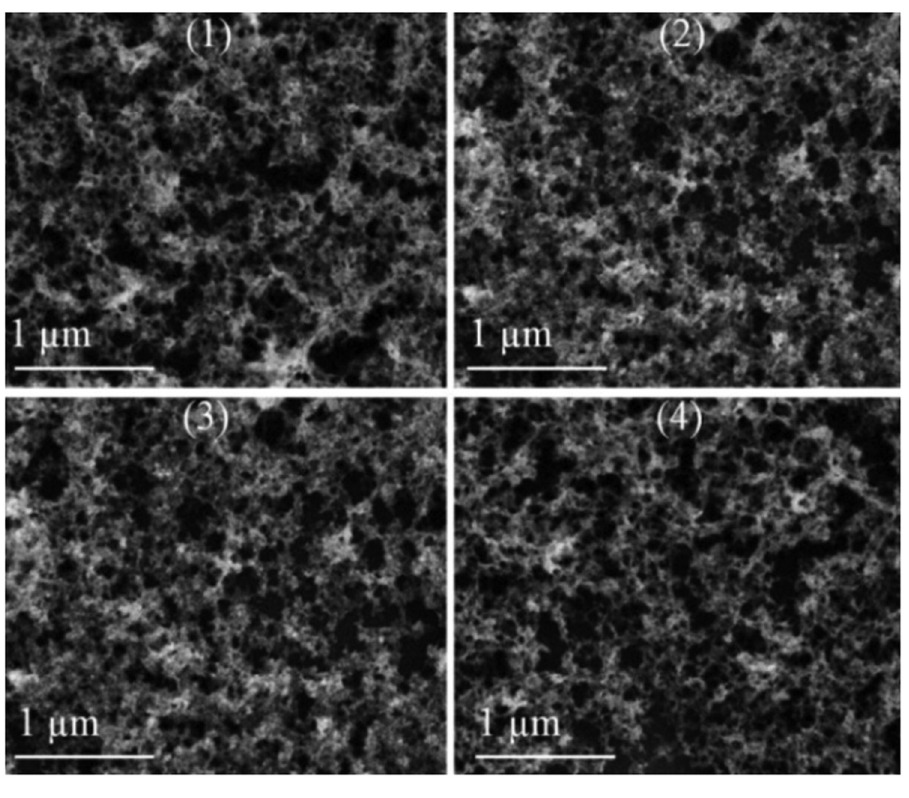
Figure 1: SEM images of ( 1 ) AMP/Tb - CIP, ( 2 ) AMP/Eu - CIP, ( 3 ) AMP/Gd - CIP, and ( 4 ) AMP/Tb 0.1 Eu 0.9 Gd 99.0 - CIP.